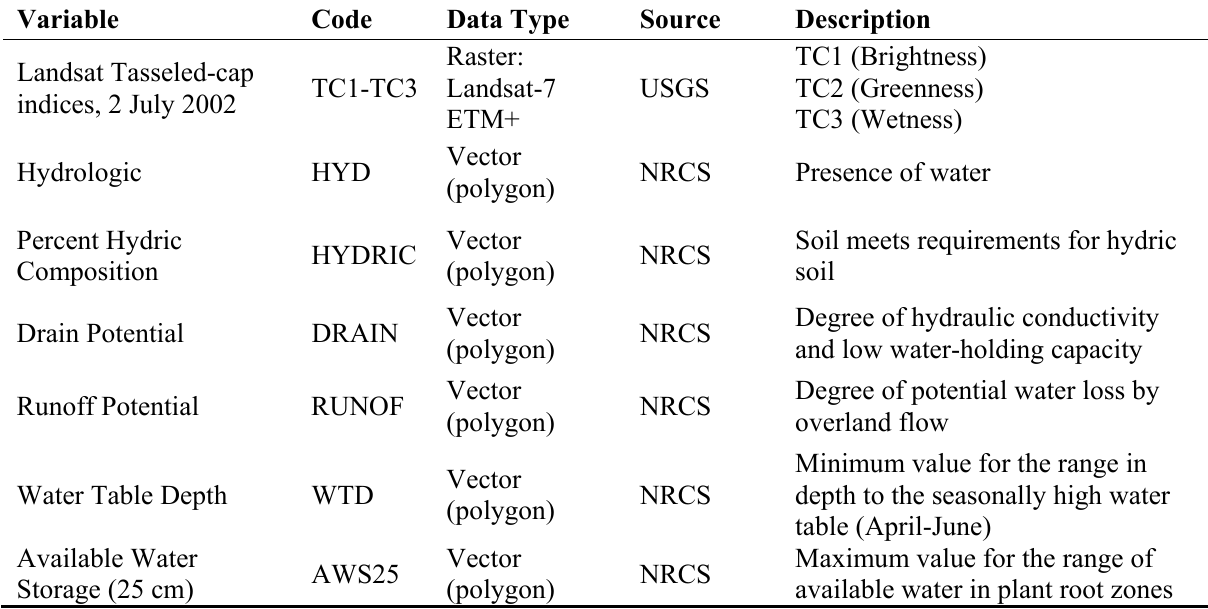
Table 1. Habitat attributes used as independent variables in habitat suitability index regression model.